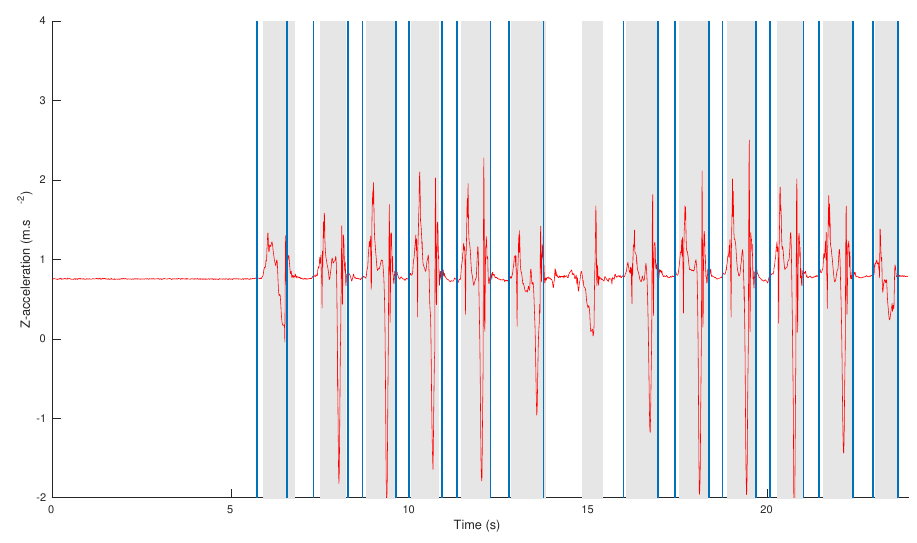
Figure 5. Comparison between step detection and annotations for a healthy subject ( top figure ) and a patient with osteoarthritis ( bottom figure ). The annotations are displayed as gray area and the step detection results as lines.